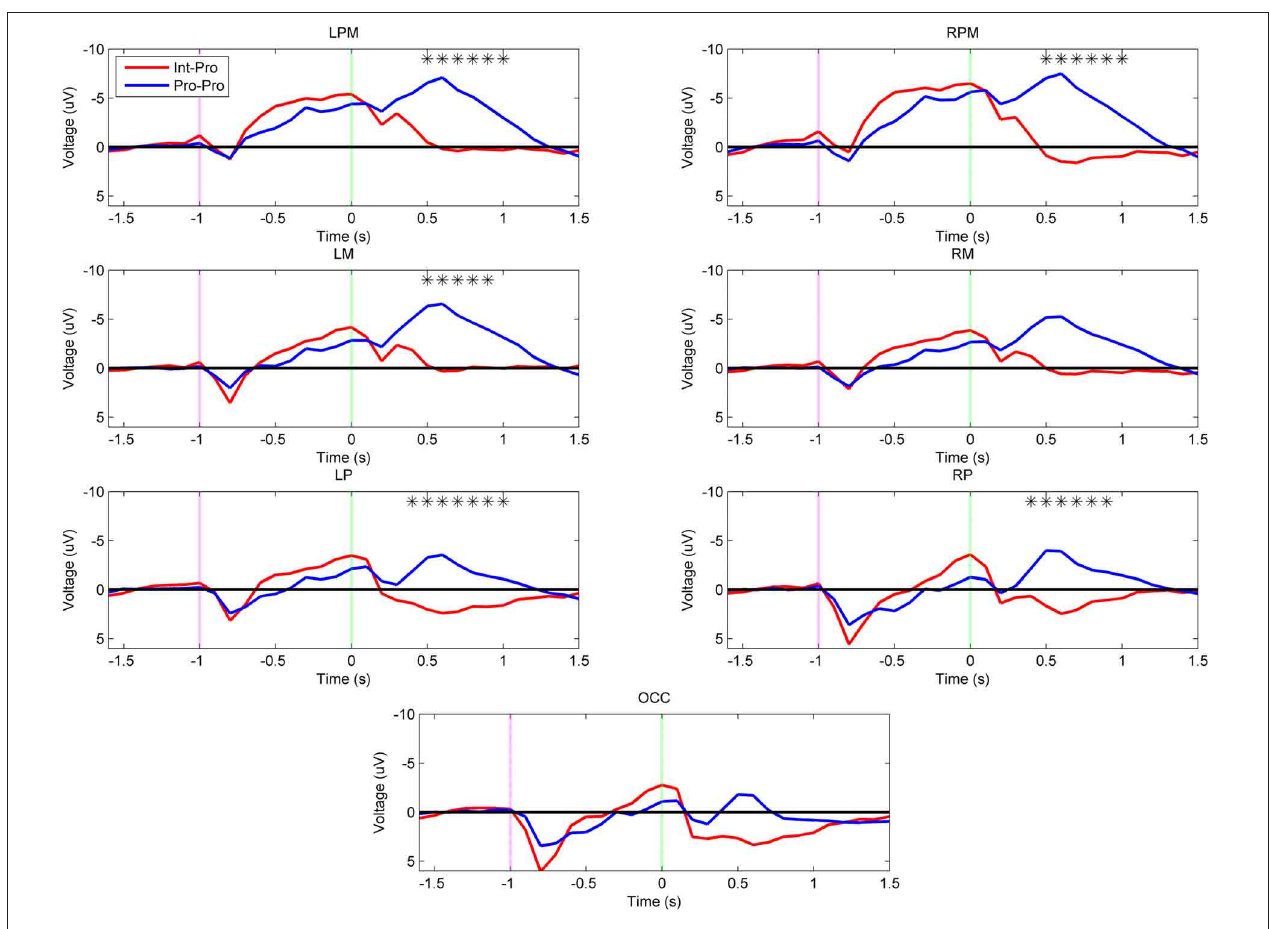
FIGURE 6 | Grand-averaged region-level voltage plots for the Int–Pro (red) and Pro–Pro (blue) groups. The planning cue is marked with a pink dotted line at –1.0s and the execution cue is marked